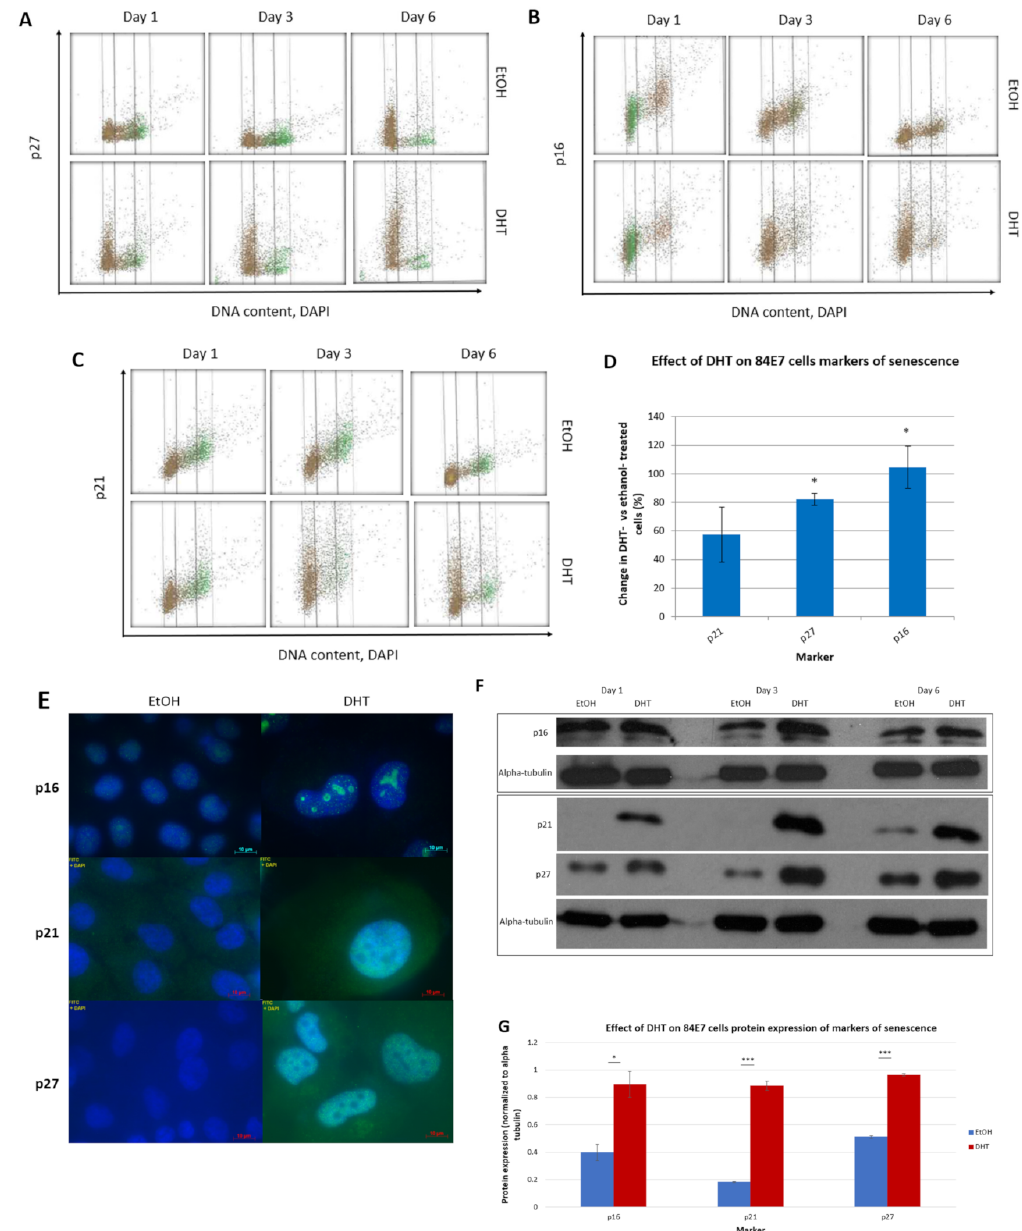
Figure 7. Effect of 84E7 AR activation on protein markers of senescence: ( A – C ) Flow cytometry data show the increased expression of senescence markers p21, p27, and p16 in 84E7 cells treated with DHT for 6 days. ( D ) Quantification of accumulation of the senescence proteins. ( E ) Localization of markers p21, p27, and p16 (merged images) in 84E7 cells treated with EtOH (left panel) or DHT (right panel) for 6 days. ( F , G ) Western blots and accompanied bar graph demonstrate the upregulation of markers for senescence by day 6 of AR activation with 10 nM DHT. Alpha-tubulin was used as a loading control. Asterisks indicate a statistically significant difference (* p < 0.05, *** p < 0.0005) seen between EtOH- and DHT-treated